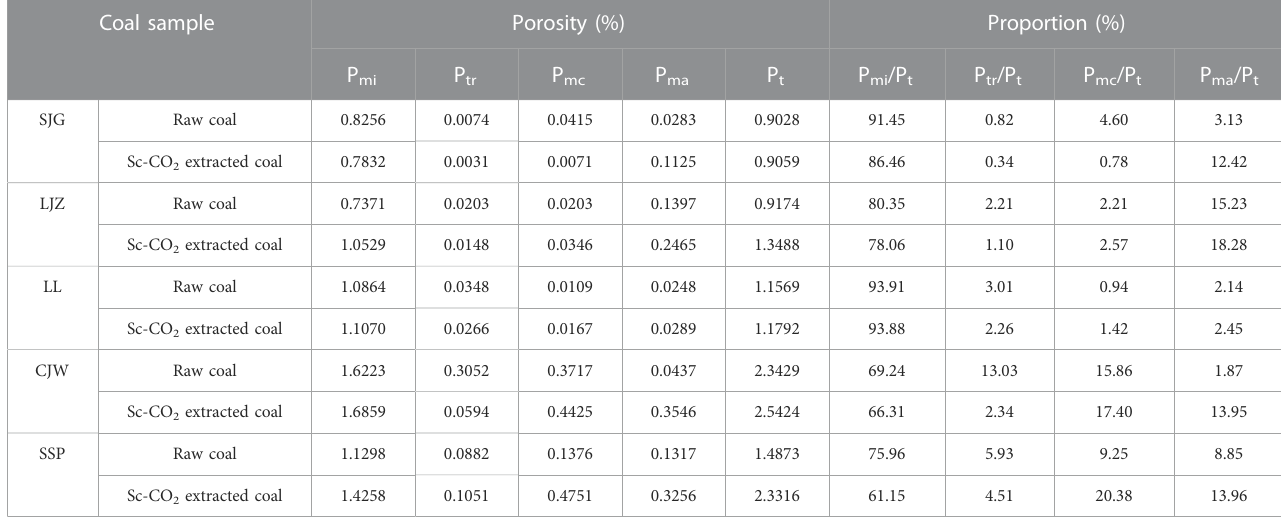
TABLE 4 The porosity of coal samples before and after Sc-CO 2 extraction. Coal sample Porosity (%)